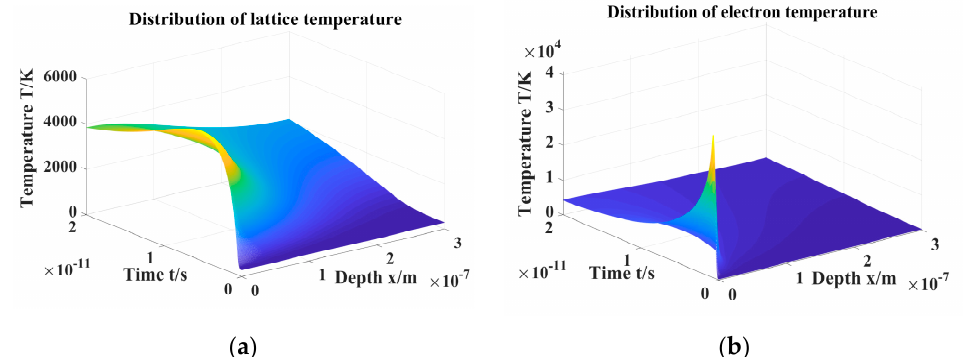
Figure 6. Distribution of temperature with the change of time and depth from the sample’s surface ( a ) Lattice ( b ) Electronic.